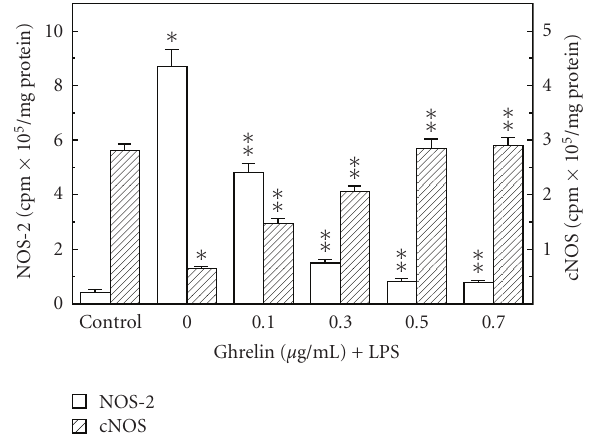
Figure 5: E ff ect of nitric oxide synthase inhibitors on the ghrelin (Gh-) induced changes in gastric mucosal cell apoptosis and the activity of caspase-3. The cells, preincubated with 30 μ M PP2, 300 μ M L-NAME (LN), 20 μ M 1400 W (14 W), 300 μ M ascorbate (As), or 20 μ M SH-5 (SH), were treated with Gh at 0.5 μ g/mL and incubated for 16h in the presence of 100 ng/mL of H. pylori LPS. Values represent the means ± SD of five experiments. ∗ P < . 05 compared with that of control. ∗∗ P < . 05 compared with that of LPS alone. ∗∗∗ P < . 05 compared with that of Gh+LPS.